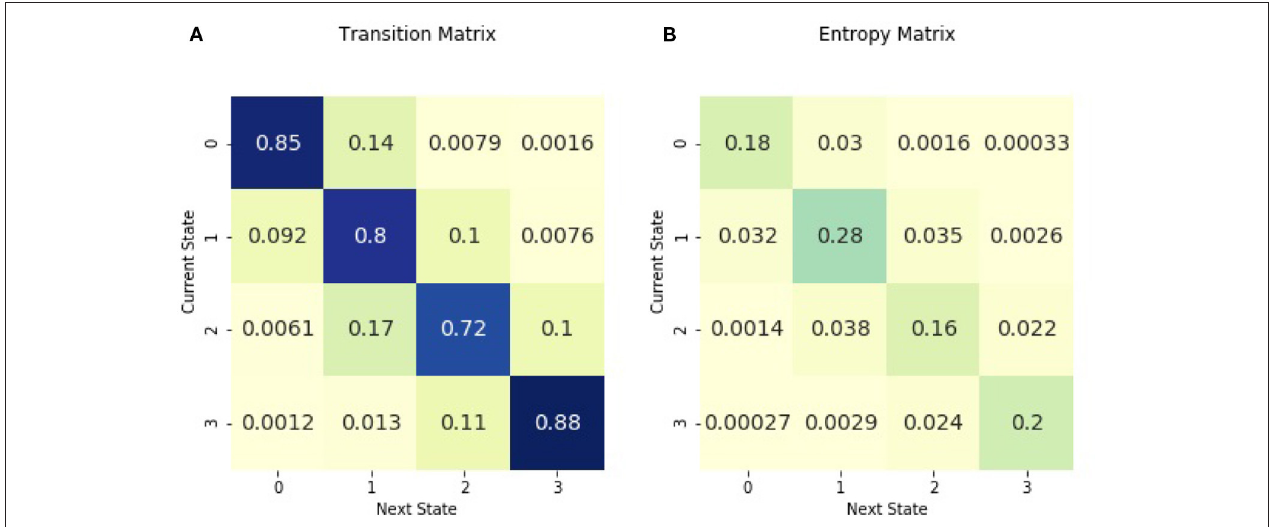
FIGURE 1 | Across all patients in the 3 days following sepsis, (A) is the transition matrix. The matrix shows the probability of transitioning from a current illness state, denoted by rows, to the subsequent illness state, denoted by columns. (B) is the entropy matrix. The probabilities in the entropy matrix are normalized from all initial illness states. Thus, values in the entropy matrix indicate the density of the observed transitions. The visual difference between the transition and entropy matrices arises from the fact that the the row values sum to one in the transition matrix while all the cell values sum to one in the entropy matrix. The figure may be interpreted as follows. The darkest cell in the entropy matrix is in the second row and the second column of (B) , where 28 % of observed transitions occurred. The corresponding cell in (A) signifies that there is an 80 % chance of remaining in illness state 1 for patients currently in illness state 1.